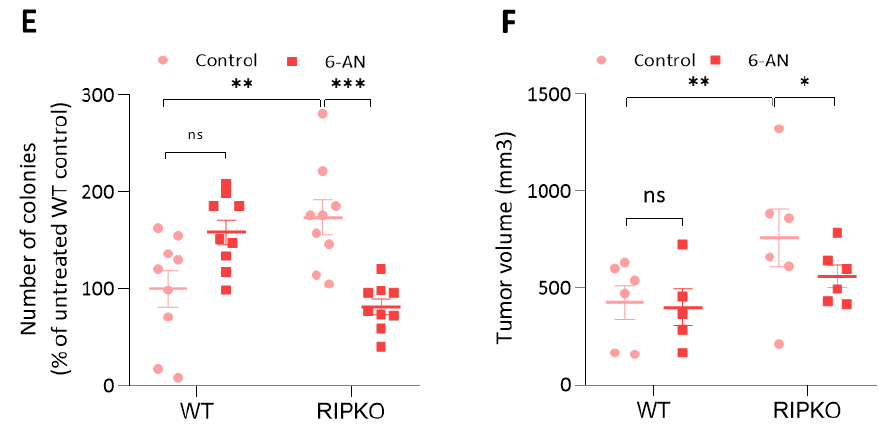
Figure 4. RIP140 deficiency sensitizes cells to G6PD inhibition. ( A ) MTT assay in WT or RIPKO MEFs after 4 days of increasing doses of 6-aminonicotinamide (6AN) at 10, 40 and 80 µ M. Values are normalized to day 1 for MEF WT or RIPKO and to control samples expressed as 100%. ( B ) MTT assay in WT or RIPKO MEFs treated with 20 µ M of 6AN. ( C ) Cell viability assessed by crystal violet staining of transformed WT or RIPKO MEFs treated for 7 days with 6AN (20 µ M). Values are normalized to that of untreated MEFs. ( D ) Cell viability assessed by crystal violet staining of MDA-MB-436 cells transfected with control siRNA (siC) or RIP140 siRNA (siRIP#1, siRIP#2) and treated for 7 days with 6AN (20 µ M). Values are normalized to that of untreated control siRNA. ( E ) Number of colonies from a colony formation in soft-agar assay of transformed WT or RIPKO MEFs transfected with shRNA control or G6PD expression lentivirus and treated for 4 weeks with 6AN (20 µ M). The data are expressed as percentages of WT untreated control samples. ( F ) Tumor volume of transformed MEF WT or RIPKO xenografted in nude mice ( n = 6) after eighteen days of 6AN administrated intra-peritoneally every other day (0.1 mg/g). All experiments were conducted at least three times. Values are means ± SEM; * p < 0.05, ** p < 0.01, *** p < 0.001, ns = not significant. The colors of asterisks correspond to the same differences as in Figure